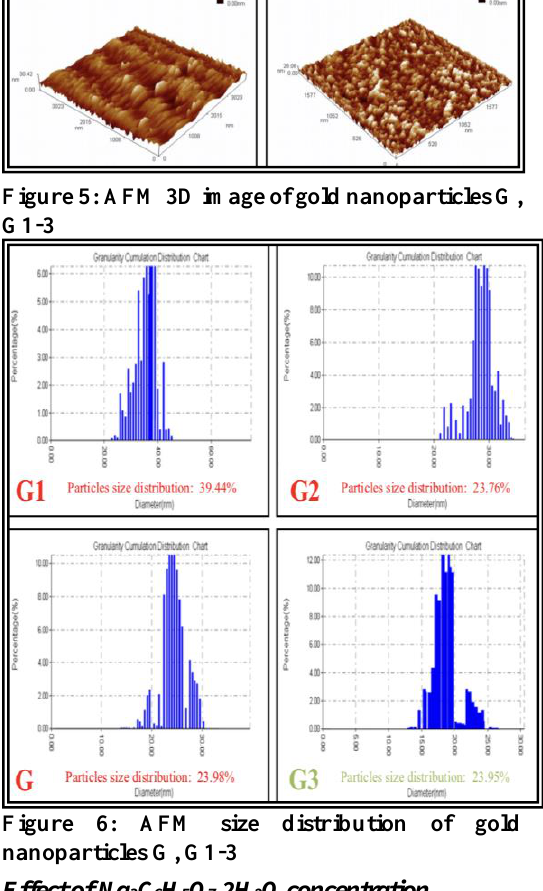
Figure 6: AFM size distribution of gold nanoparticles G, G1-3 Effect of Na 3 C 6 H 5 O 7 .2H 2 O concentration Gold nanoparticles G3 and G7-9